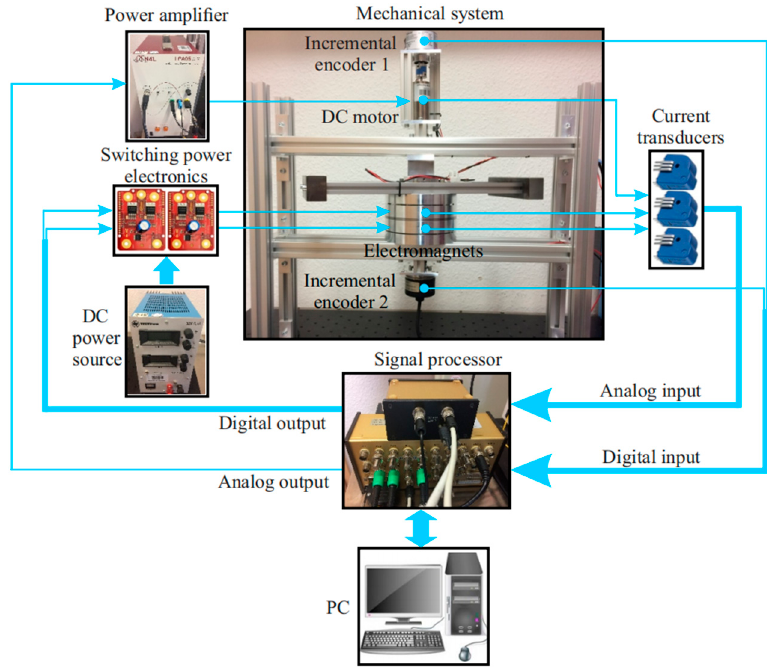
Figure 5. Complete experimental system.